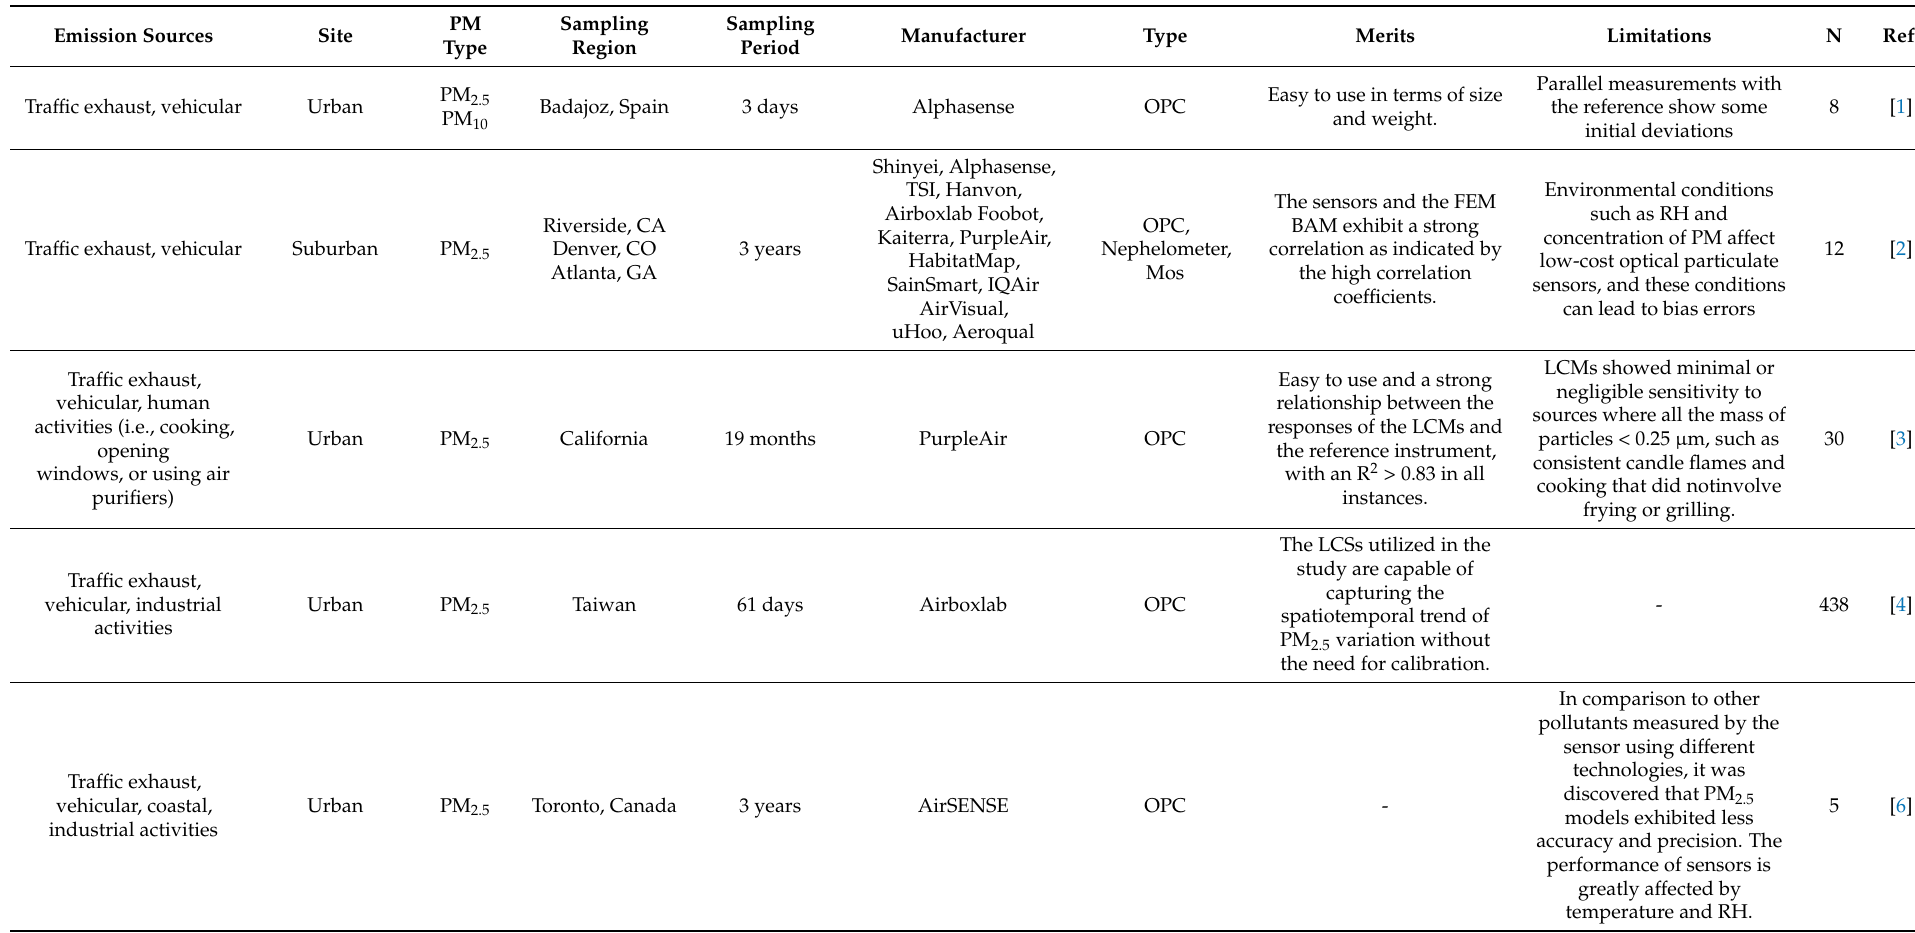
Table 2. Summarization of characteristics for LCSs evaluating particulate